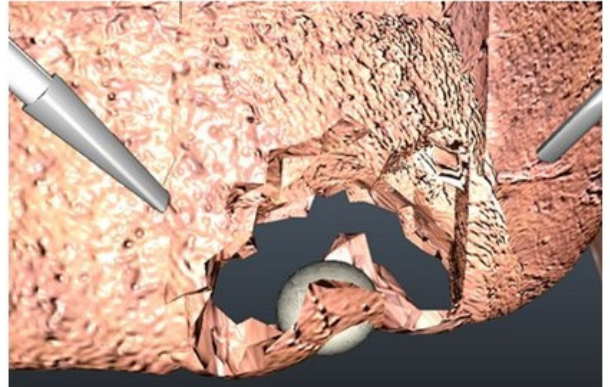
Figure 3. Simulated metastasectomy.